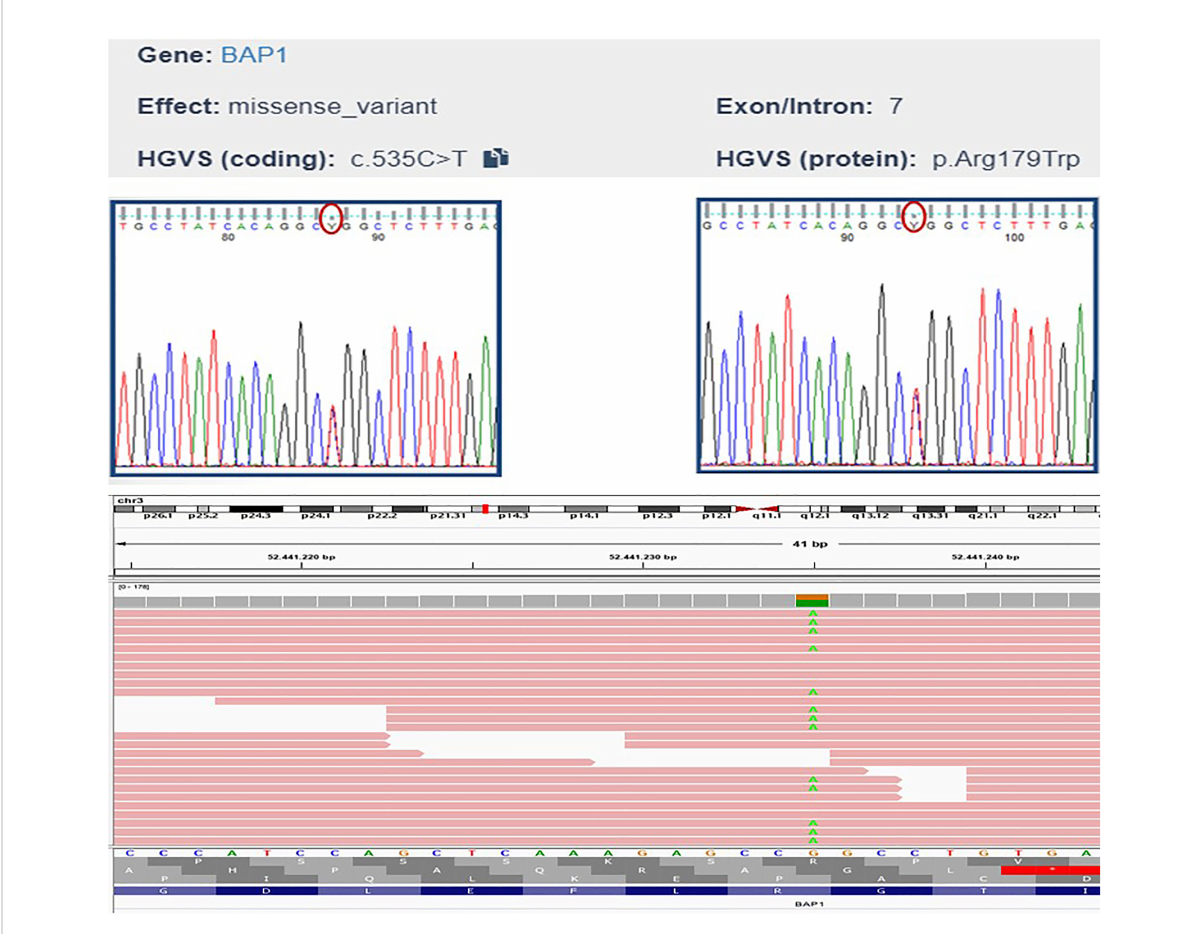
FIGURE 3 Familial history of neoplasia in the patient ’ s relatives (A) . The histological review of the son ’ s colorectal carcinoma sample showed adenocarcinoma ( B , haematoxylin and eosin staining, 100x original magni fi cation) that was negative for BAP1 expression ( C , immunohistochemistry, 100x original magni fi